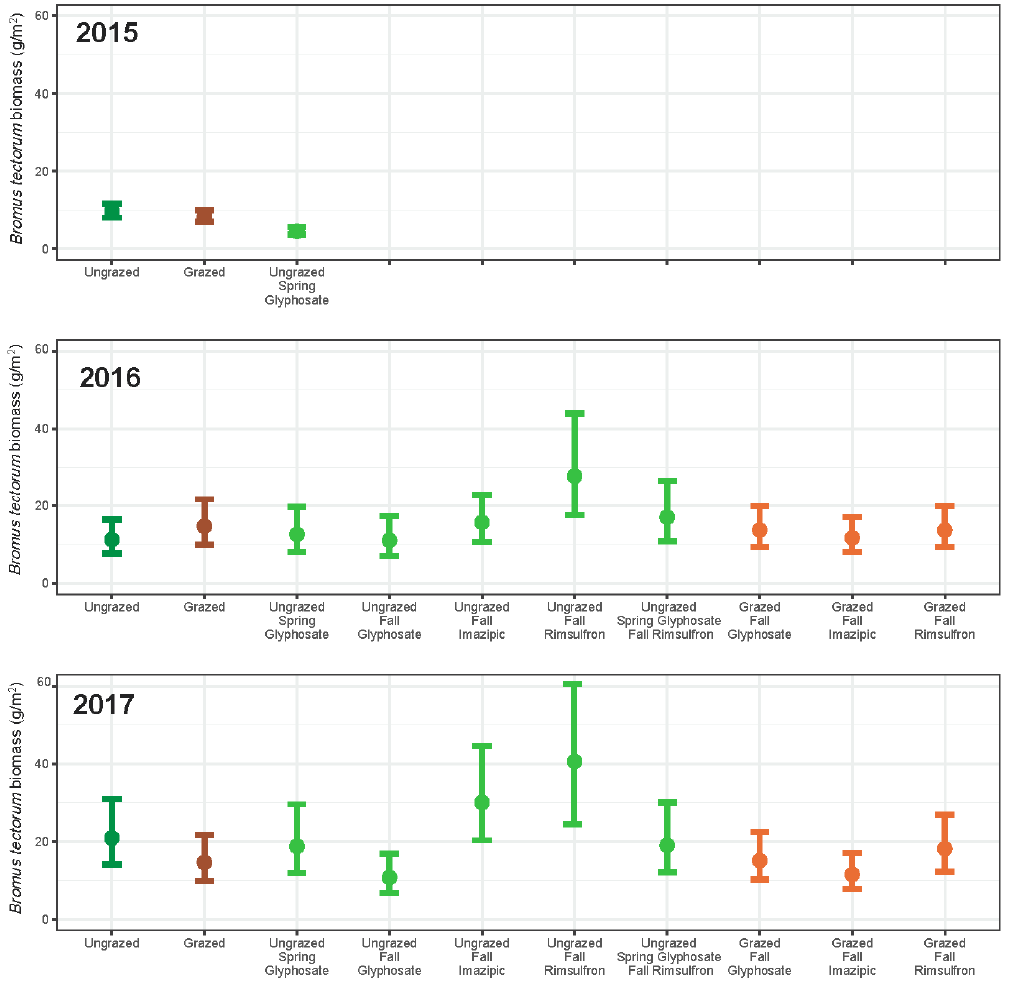
Figure 1. Fitted model results for Bromus tectorum biomass (g; mean ± SE) response to grazing, herbicide and integrated treatments at Red Bluff, Montana in 2015, 2016, and 2017. Fall herbicide treatments were implemented after the summer data collection in 2015, so these treatments do not show results in 2015. Furthermore, fall herbicide results in 2016 and 2017 represent treatments implemented in the prior years. Data shown are predicted values from linear mixed effects models, and thus the means are not identical to means from the raw data.